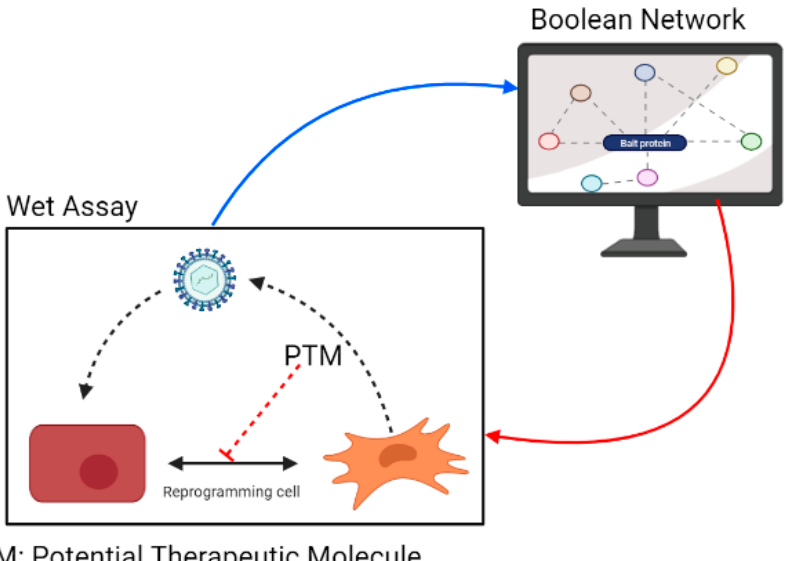
Figure 2. Implementation of BNs to study virus-induced EMT and EndMT and evaluate molecules that can interfere with cellular mechanisms that are activated by viral